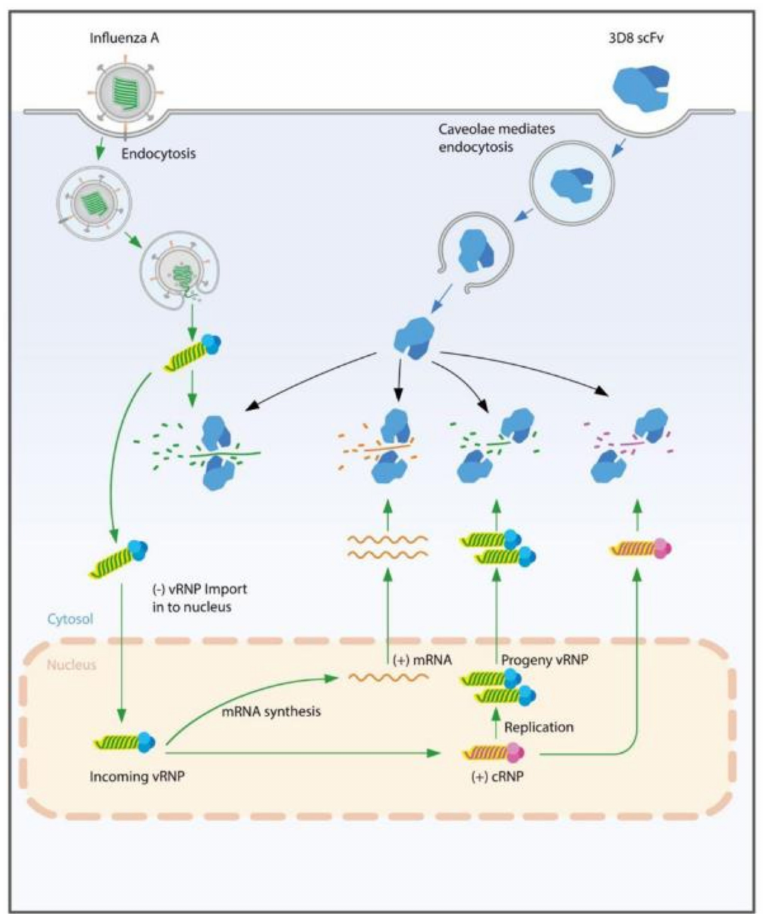
Figure 5. Proposed model of the antiviral mechanism of action of 3D8 scFv. 3D8 scFv, which is localized by cavolae-mediated endocytosis in the cell’s cytoplasm, does not inhibit one specific step in the virus’s life cycle. Three different viral RNAs could be targets of 3D8 scFv in all stages of IAV’s life cycle. 3D8 scFv could hydrolyze all types of IAV RNAs/RNP at different infection stages such as viral entry, viral protein biosynthesis, and virus exit in the cytoplasm of infected